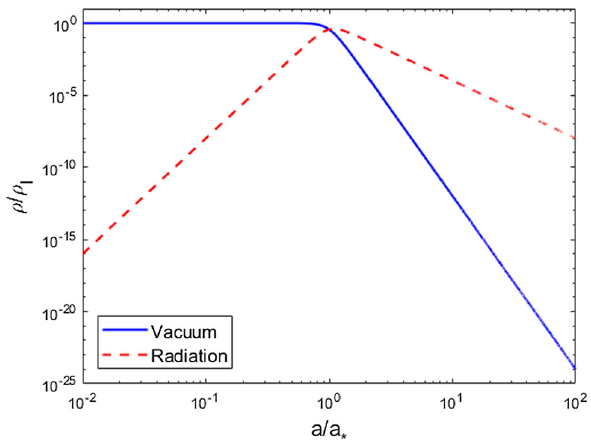
Fig. 1 Inflationary period. It is shown the evolution of the energy den- sities (9.5) of vacuum and relativistic matter before and after the tran- sition point a ∗ ∼ 10 − 29 from inflation to the early radiation epoch (see the text). The constant vacuum energy density during inflation decays into radiation and the standard FLRW regime